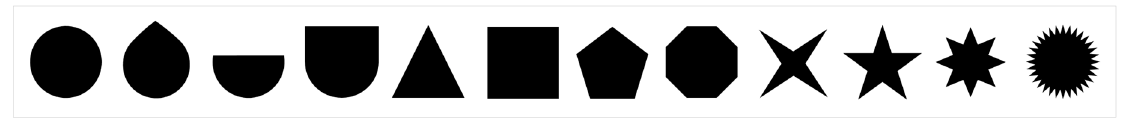
Figure 1. Stimulus material used in the present study, comprised of 12 geometric shapes.